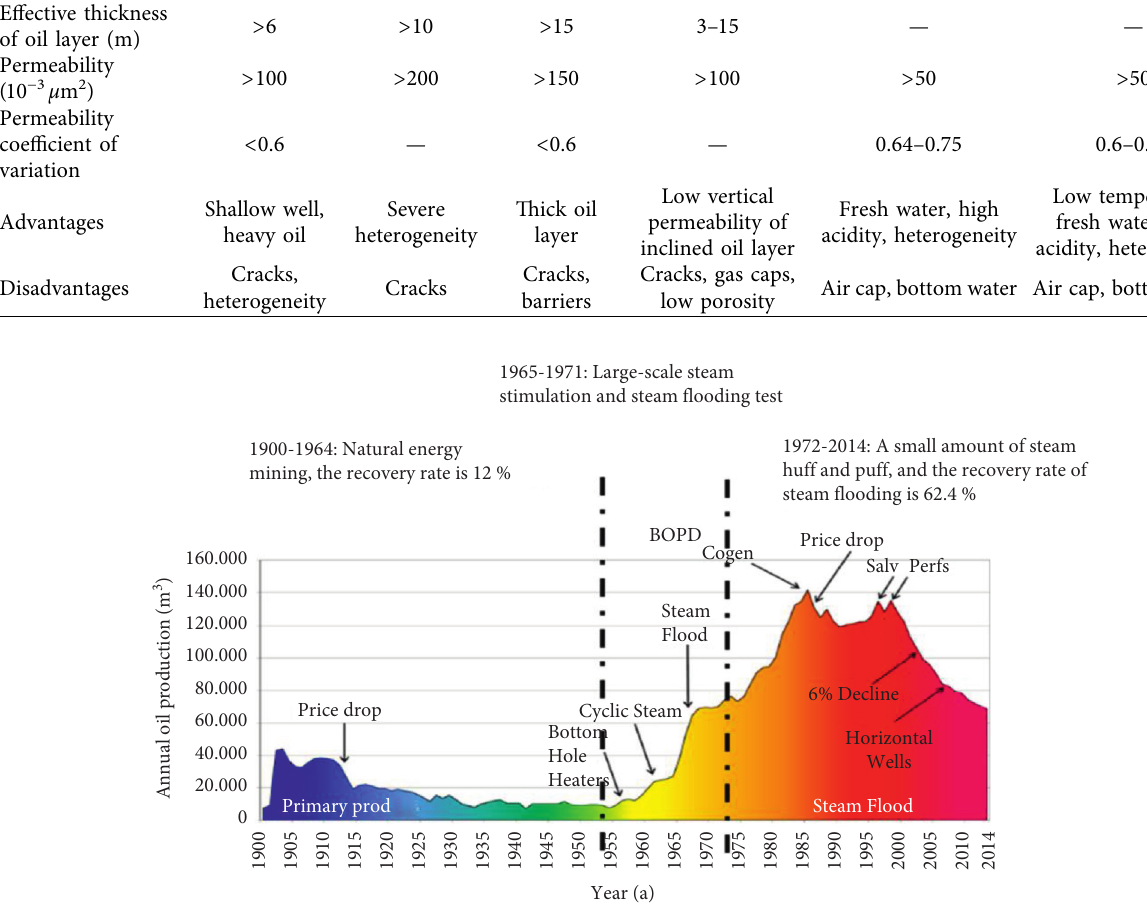
Figure 1: Annual oil production of the Coen River